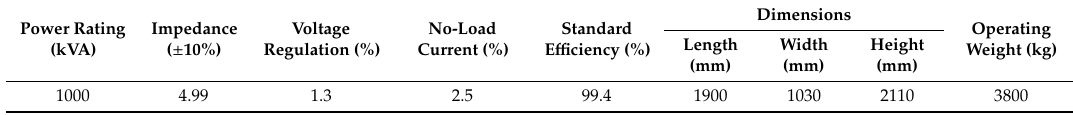
Table 1. Detailed specifications of the tested mold transformer.